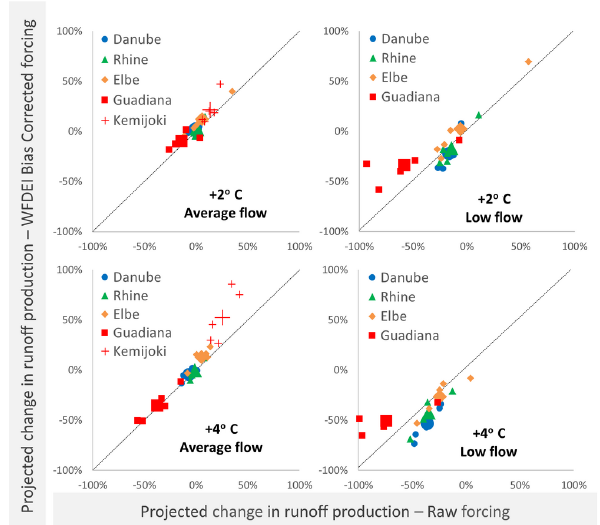
Figure 9. Correlation between projected change in basin aver- aged runoff production derived from WFDEI-bias adjusted and raw Euro-CORDEX data, for both annual average (left panels) and 10th percentile (right panels) runoff production. Correlation is ex- amined at + 2 ◦ C SWL (top panels) and at + 4 ◦ C SWL (bottom panels). Small markers represent the value of each individual model and bigger markers correspond to ensemble mean